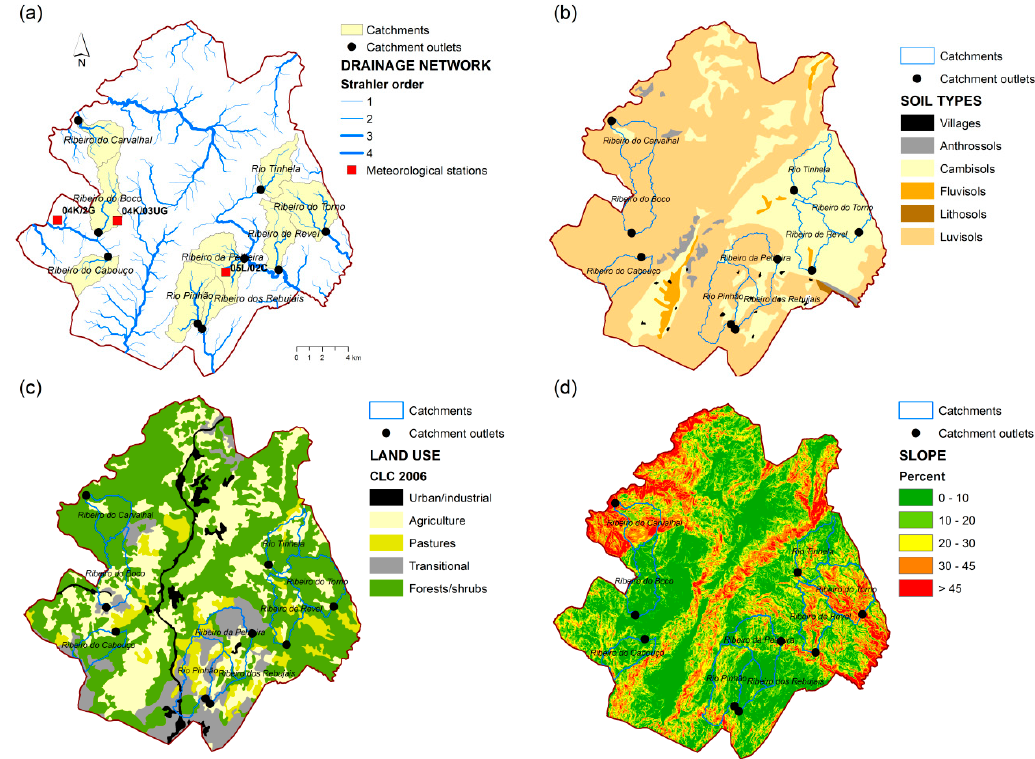
Figure 8. Geographic data used in the hydrologic simulations based on ArcSWAT. ( a ) Hydrographic and meteorological data; ( b ) Soil data; ( c ) Land use data; ( d ) Topographic data.